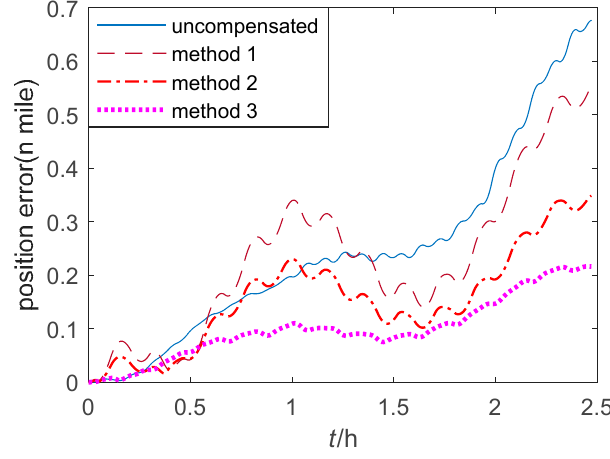
Figure 11. The position error of single-axis RINS in the quasi-static state.